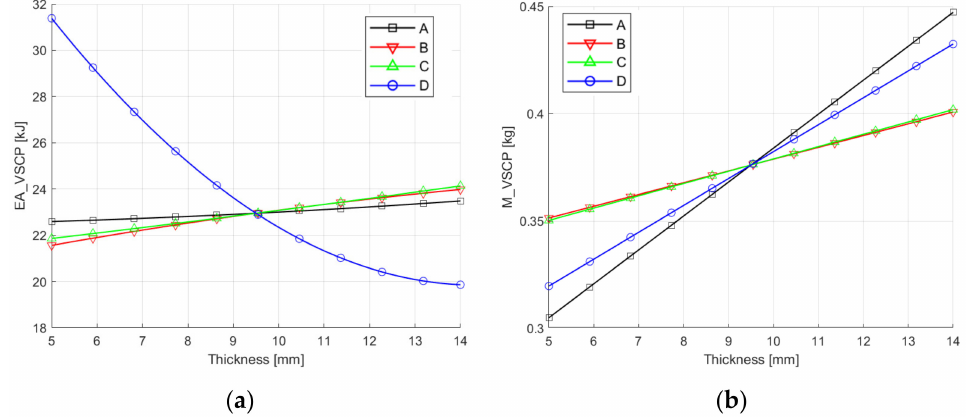
Figure 15. Effect curves of thickness: ( a ) Effect of parameters on EA_VSCP; ( b ) Effect of parameters on M_VSCP.